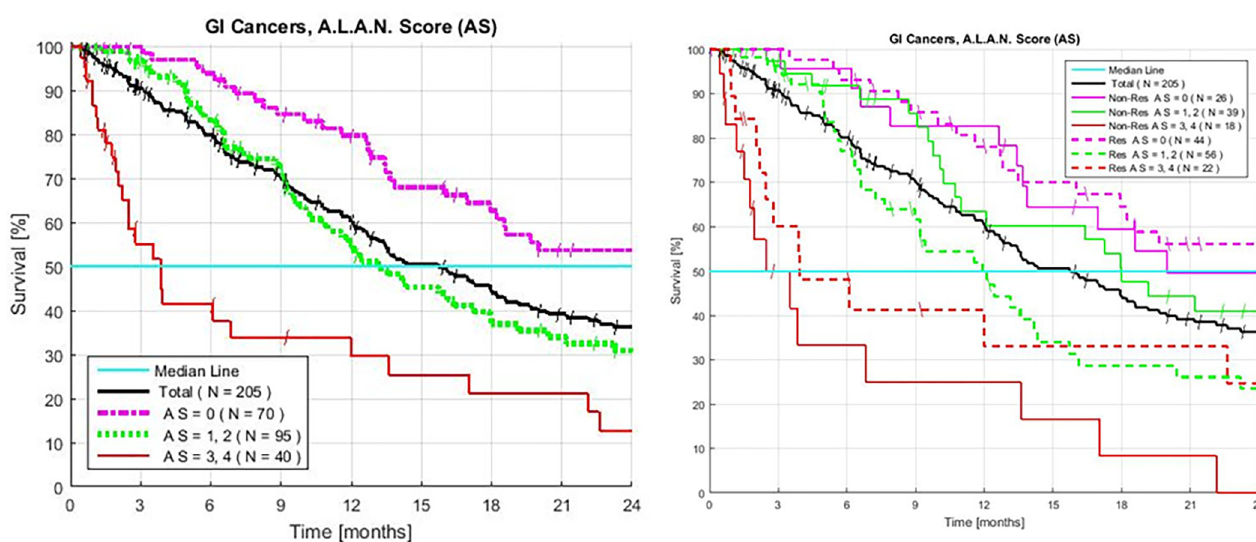
Fig 5. A. Overall combined Kaplan-Meier survival of patients with advanced gastrointestinal cancers treated with GFLIO. Resistant colon, and both pancreatic, intrahepatic bile duct tumors with and without prior treatment (AS 0 vs. 1–2, P < 9.1x10 -3 , HR 1.70. AS 0–2 vs. 3–4, P < 1.2x10 -6 , HR 2.69). B. Survival and AS 0, 1–2 or 3–4, tests ( < 3.5 g/dL Albumin; > 3.0 NLR; > 8,000/mm 3 neutrophils and a < 2.1 LMR), of patients with advanced gastrointestinal cancer treated with GFLIO. Resistant colon, and both pancreatic and intrahepatic bile duct tumors with and without prior